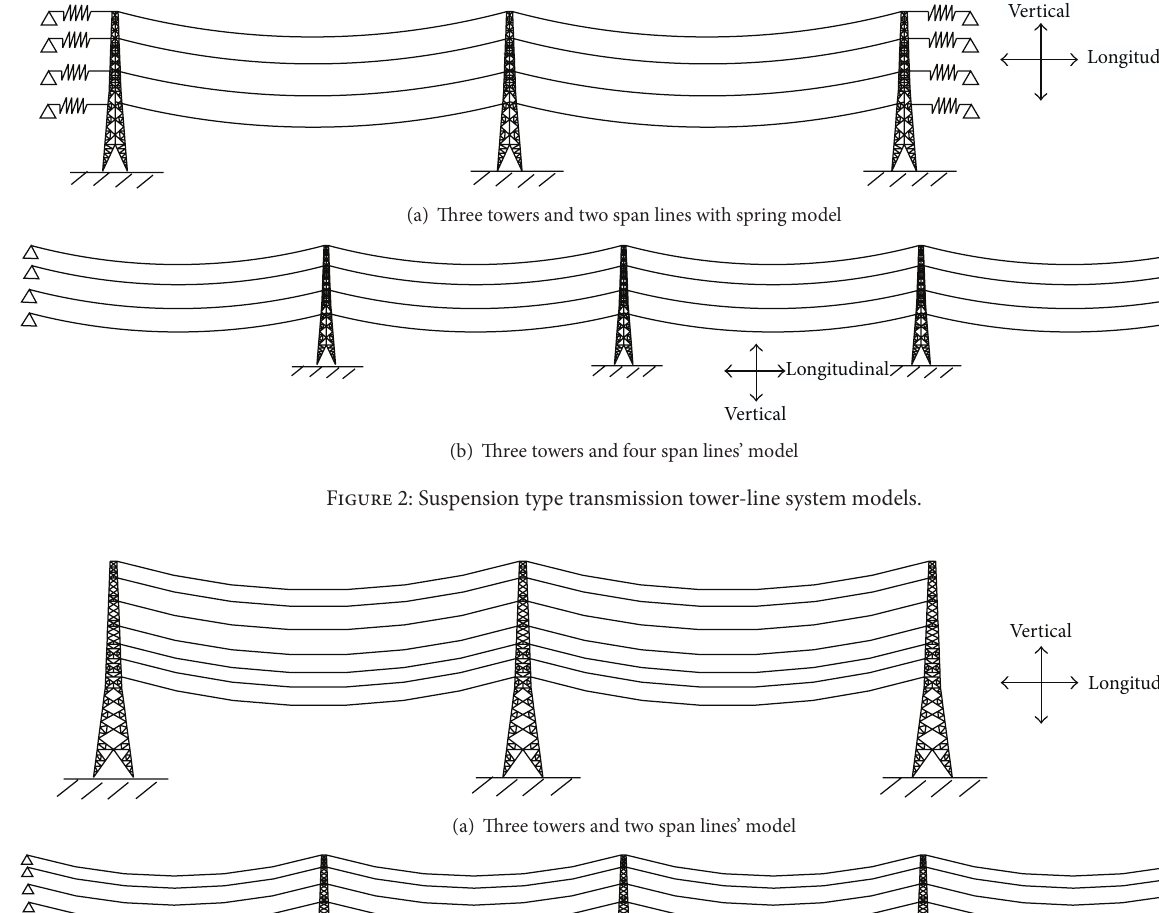
Figure 3. Three towers and two span lines’ model (Model 3) and three towers and four span lines’ model (Model 4) are created, respectively.